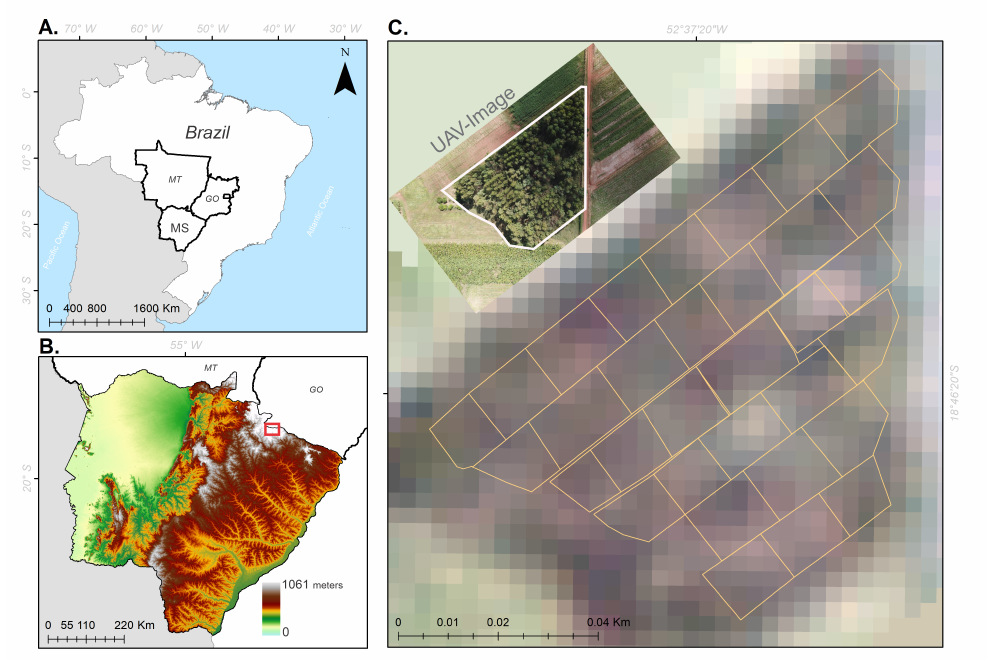
Figure 1. Location of the study area in Brazil ( A ), in the state of Mato Grosso do Sul ( B ) and delimitation of xperimental plots in Chapadão do Sul ( C